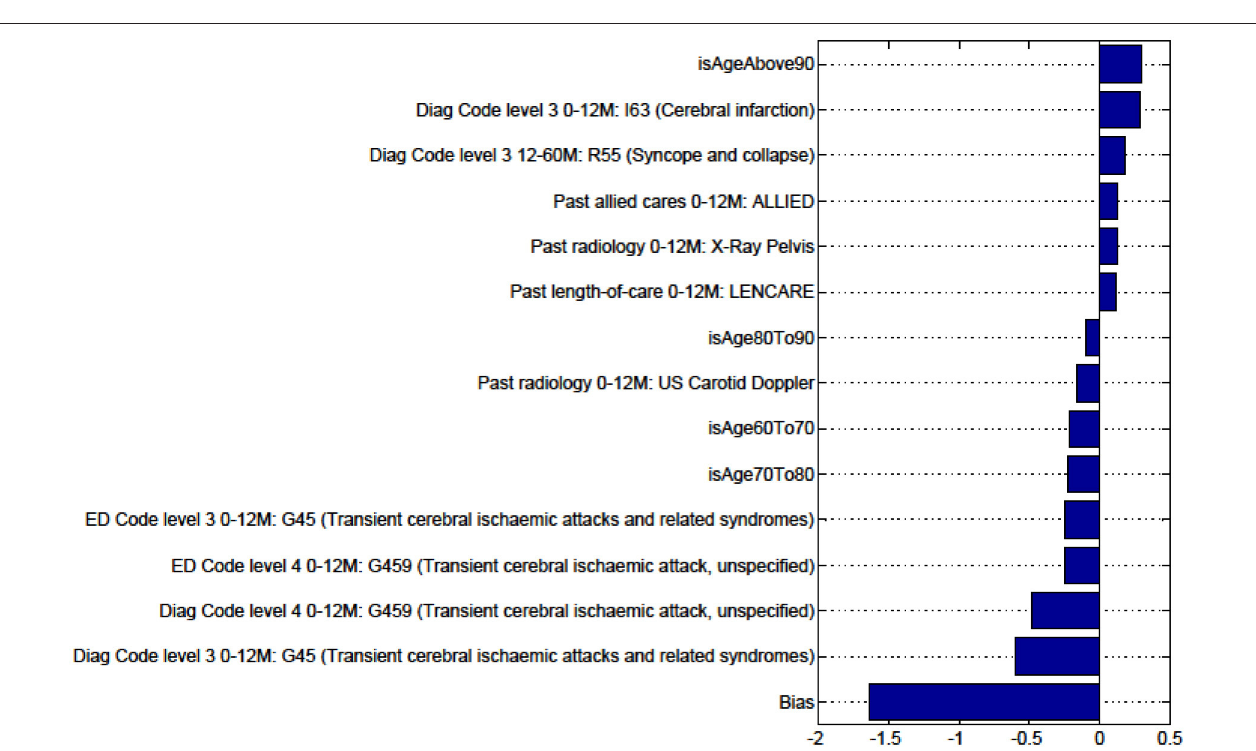
Frontiers in Neurology |